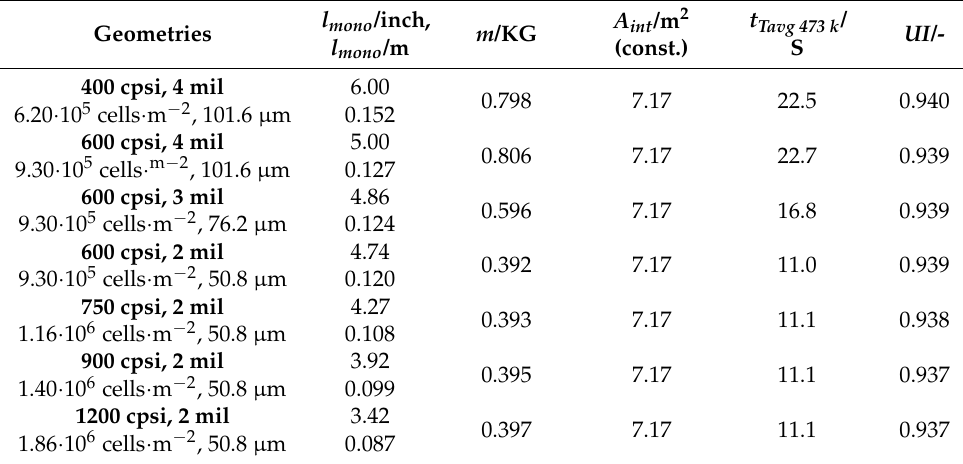
Table 3. Overview of relevant parameter for the adapted monoliths.